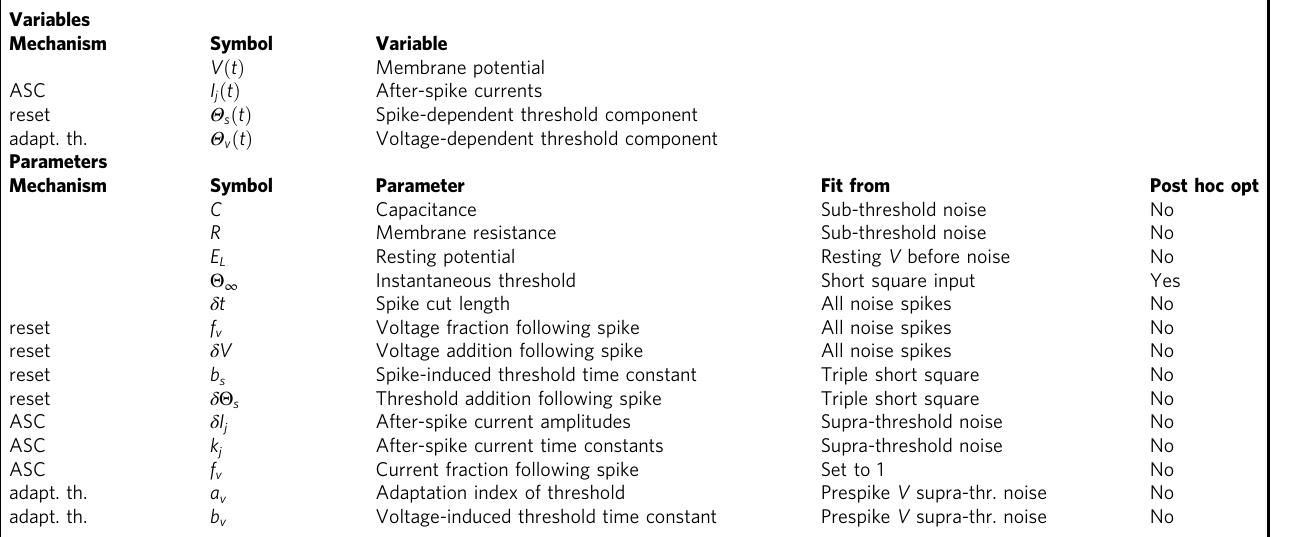
Table 1 Description of model parameters and variables Variables